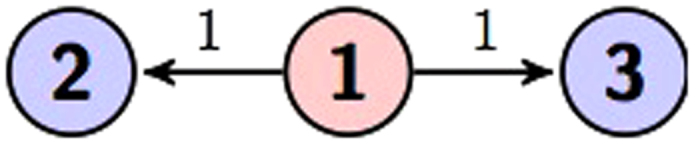
Three qudit graph.